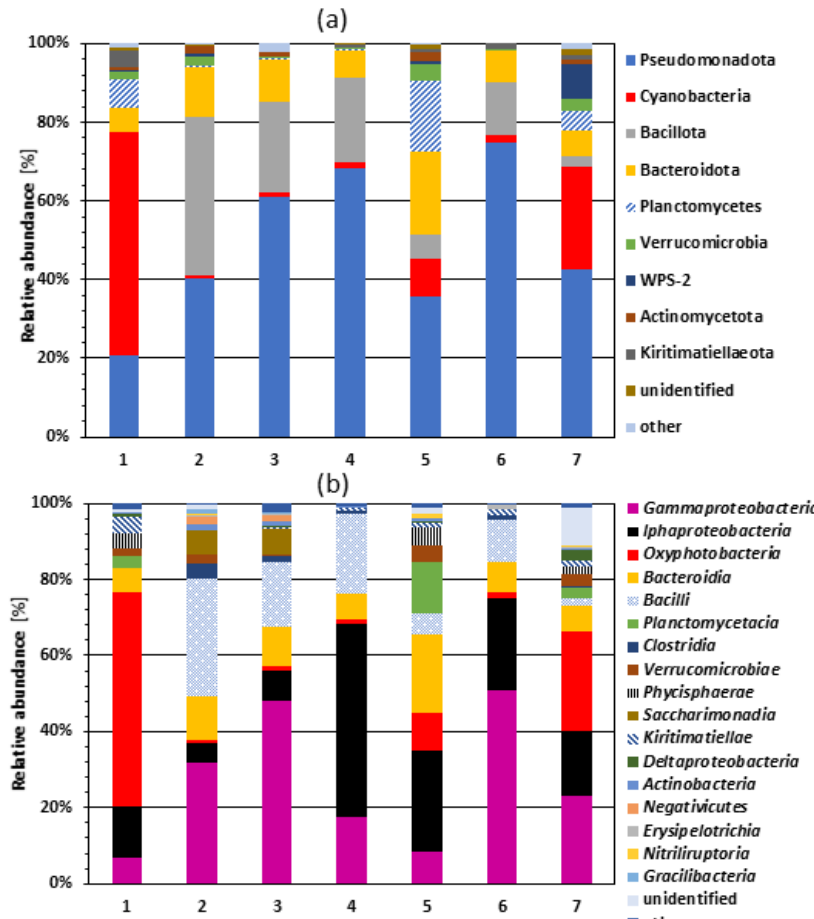
Figure 6. Relative abundance of major taxonomic groups at ( a ) phylum and ( b ) class level for bac- teria and archaea. The most abundant operational taxonomic units (OTUs) at different levels for all experiments are listed (>1% in at least one sample), while all other OTUs were combined and shown as “other”. The samples analyzed were denoted using numbers as follows: (1) inoculum, (2) brewery wastewater before pasteurization, (3) brewery wastewater following pasteurization, (4) mid-exponential growth phase (11th day) during A. platensis cultivation under continuous illumi- nation in brewery wastewater with 1 g/L NaCl and 5 g/L NaHCO 3 , (5) stationary phase (21st day) during A. platensis cultivation under continuous illumination in brewery wastewater with 1 g/L NaCl and 5 g/L NaHCO 3 , (6) mid-exponential growth phase (11th day) applying photoperiod (16:8 h light:dark) during A. platensis cultivation in brewery wastewater with 1 g/L NaCl and 5 g/L NaHCO 3 , and (7) stationary phase (21st day) applying photoperiod (16:8 h light:dark) during A. platensis cultivation in brewery wastewater with 1 g/L NaCl and 5 g/L NaHCO 3